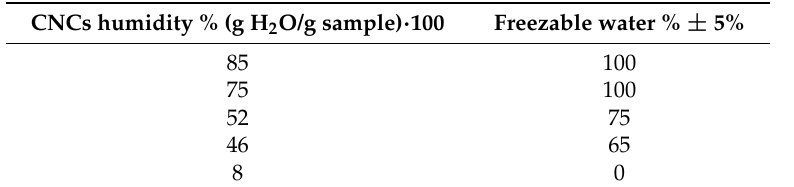
Table 2. CNCs freezable water content assessed by DSC.